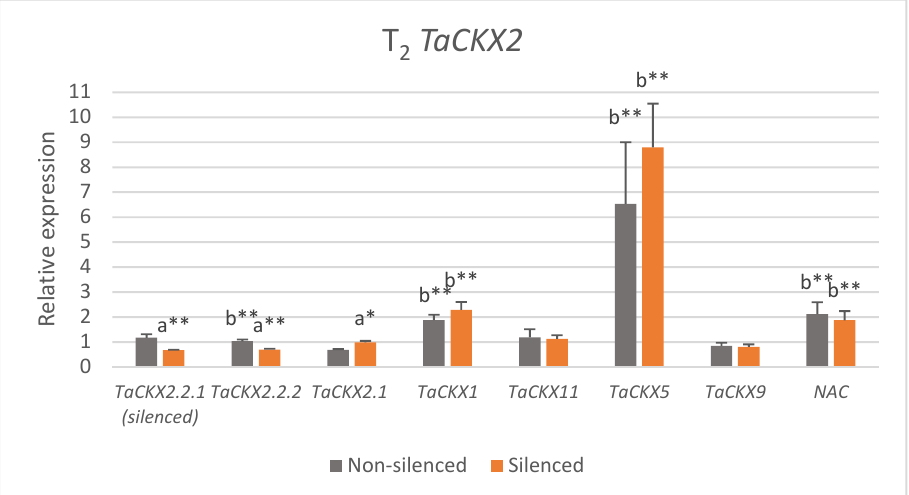
Figure 2. Relative values of expression of TaCKX2 and other TaCKX GFMs, and NAC in silenced and nonsilenced TaCKX2.2.1 lines of T 2 . The error bars denote ± SE. Different letters mean significant differences: a—between silenced and nonsilenced lines; b—between silenced TaCKX2.2.1 and others. * significant at p ≤ 0.05; ** significant at p ≤ 0.01.